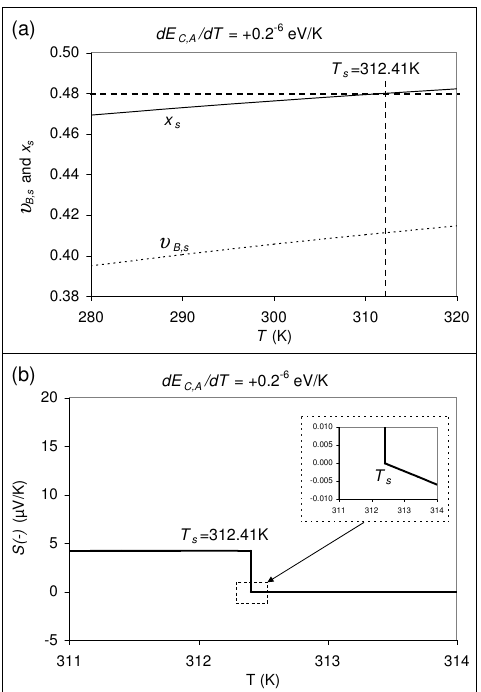
Figure 7. ( a ) x s and υ B , s vs. T calculated for the example of Figure 4 with ∂ E C , A / ∂ T = + 0.2 × 10 − 6 eV/K. For x = 0.48, T s = 312.41K. ( b ) S ( − ) vs. T for x = 0.48. The inset shows the same data with a better resolution. At the lower kink of the discontinuity, S ( − ) = 0 precisely; S ( − ) decreases with increasing T very slowly at a rate of − 0.0037 ( µ V/K) per 1 K.